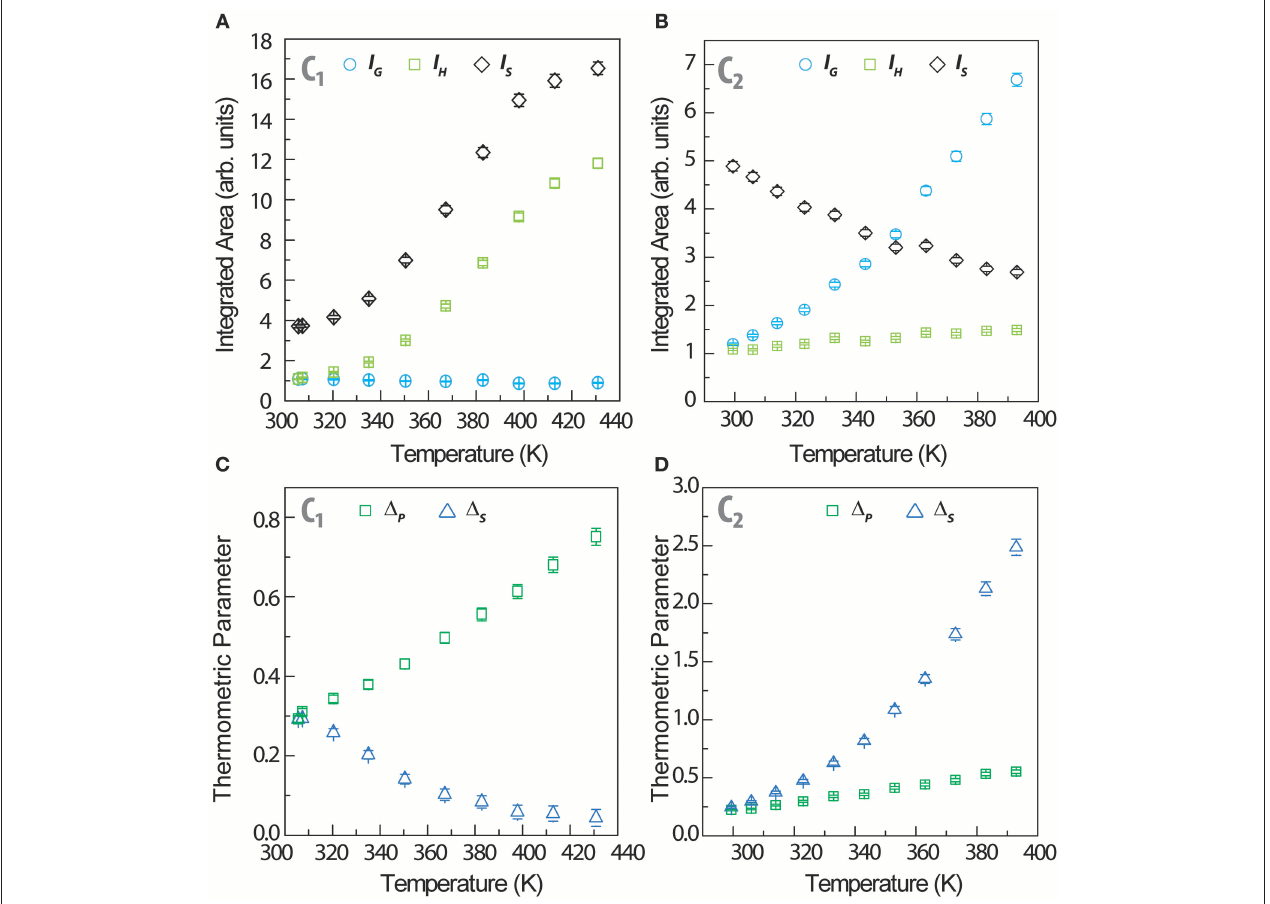
FIGURE 2 | Temperature dependence of the integrated areas of I H , I S (Er 3 + ) and I G (Tm 3 + ) for (A) C 1 and (B) C 2 . The corresponding 1 P and 1 S thermometric parameters are presented in (C) and (D) ,